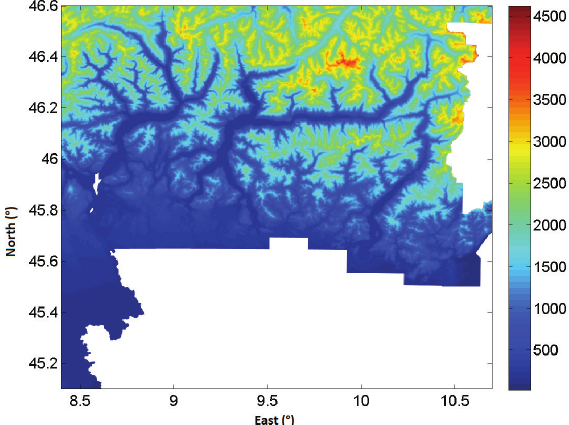
Figure 2. Unified HELI-DEM DTM (HD-1) obtained through the merging of Lombardy, Piedmont and Swiss low/medium